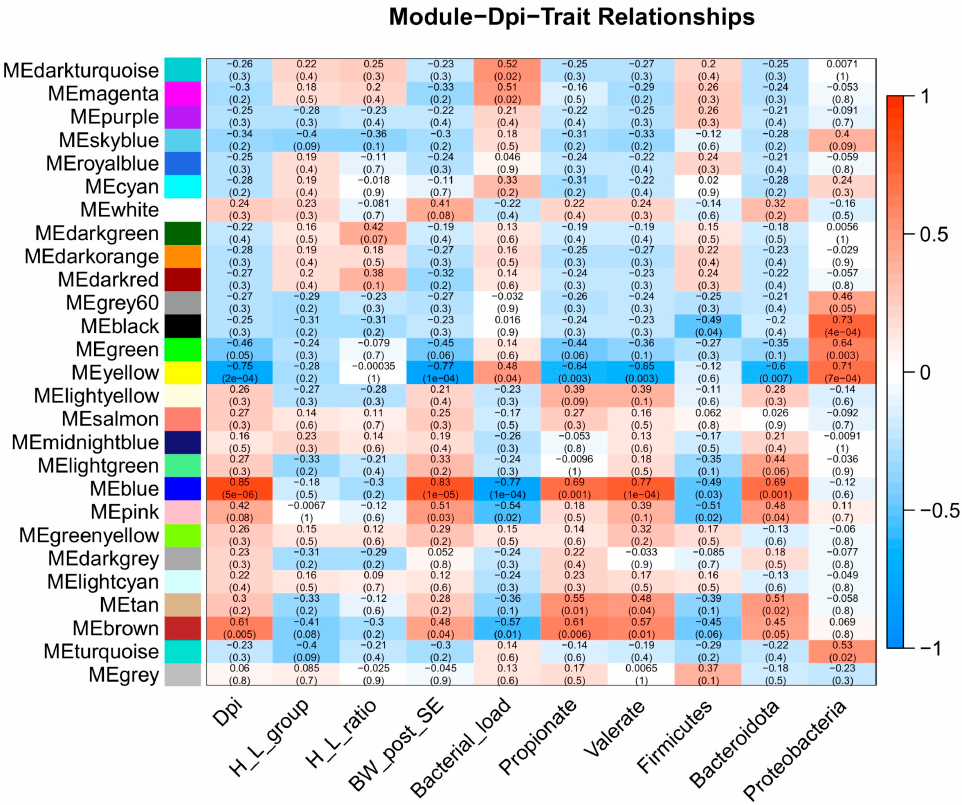
Figure 5. Heat map of module-trait relationships, each cell has two values. The upper is the absolute value of the correlation coefficient, and the down is the p -value. Red and blue colors represent positive and negative correlations, respectively. Dpi: day post-infection; H_L: H/L ratio; BW_post_SE: body weight after Salmonella Enteritidis infection.